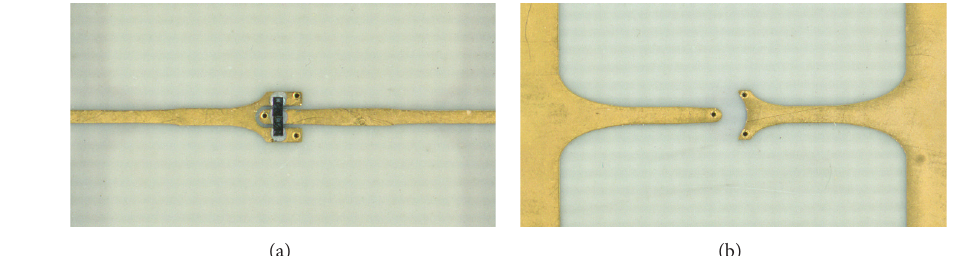
Figure 5: Fabricated wideband frequency tripler (Type A): (a) top view and (b) bottom view. The dimension is 540 mil × 250 mil.